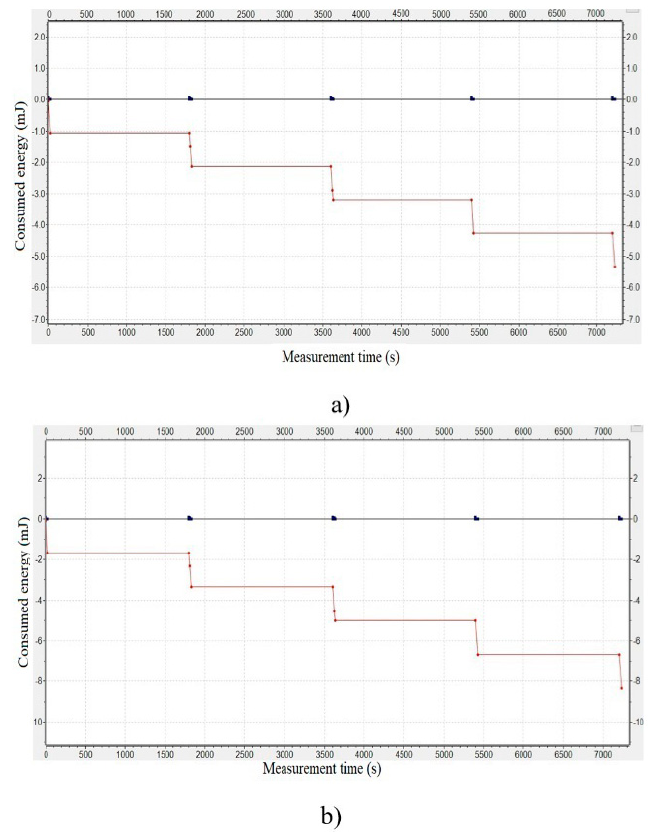
Figure 8. Energy consumption of wireless (LoRa) communication sensor node: ( a ) simulation result without security model; ( b ) simulation result with the proposed security model.